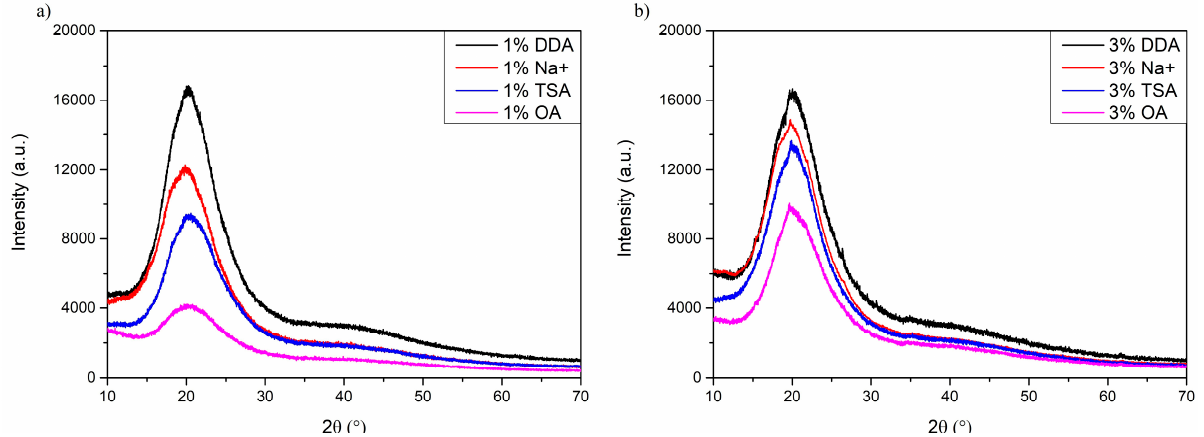
Figure 8. X-ray pattern of surface-modified montmorillonite clays.